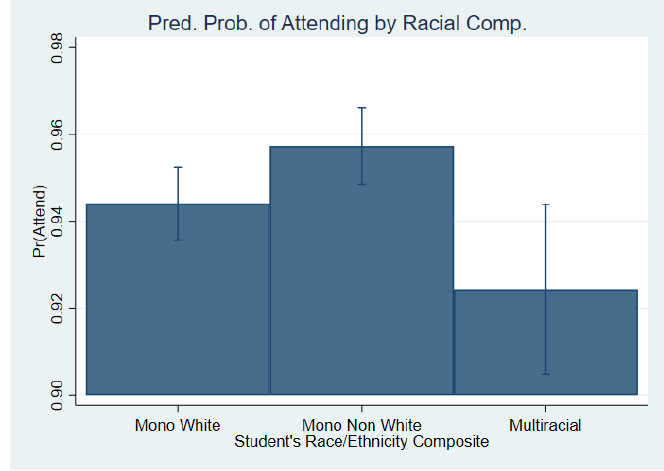
Figure 2. Pred. Prob. of Enrollment by Racial Comp. using ELS data.